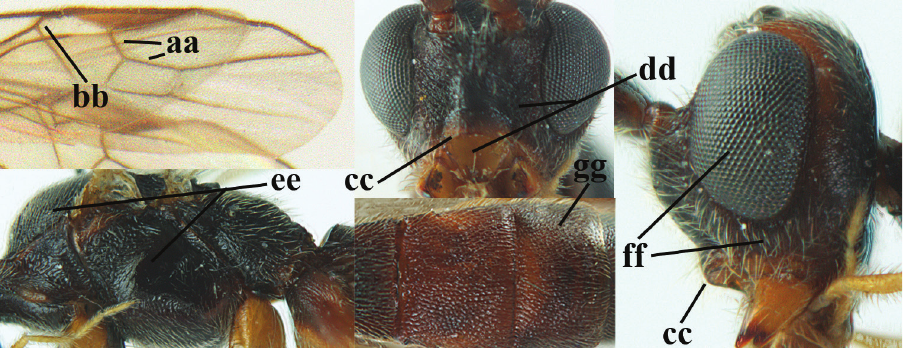
Antennal segments of ♀ 50–71 and head usually entirely brownish yellow (a), of ♂ 52–68 (but males of A. pallidator practically unknown); scapus brownish yellow or reddish brown (b) and robust in lateral view (c); [fourth metasomal tergite largely superficially granulate; first tergite lamelliform